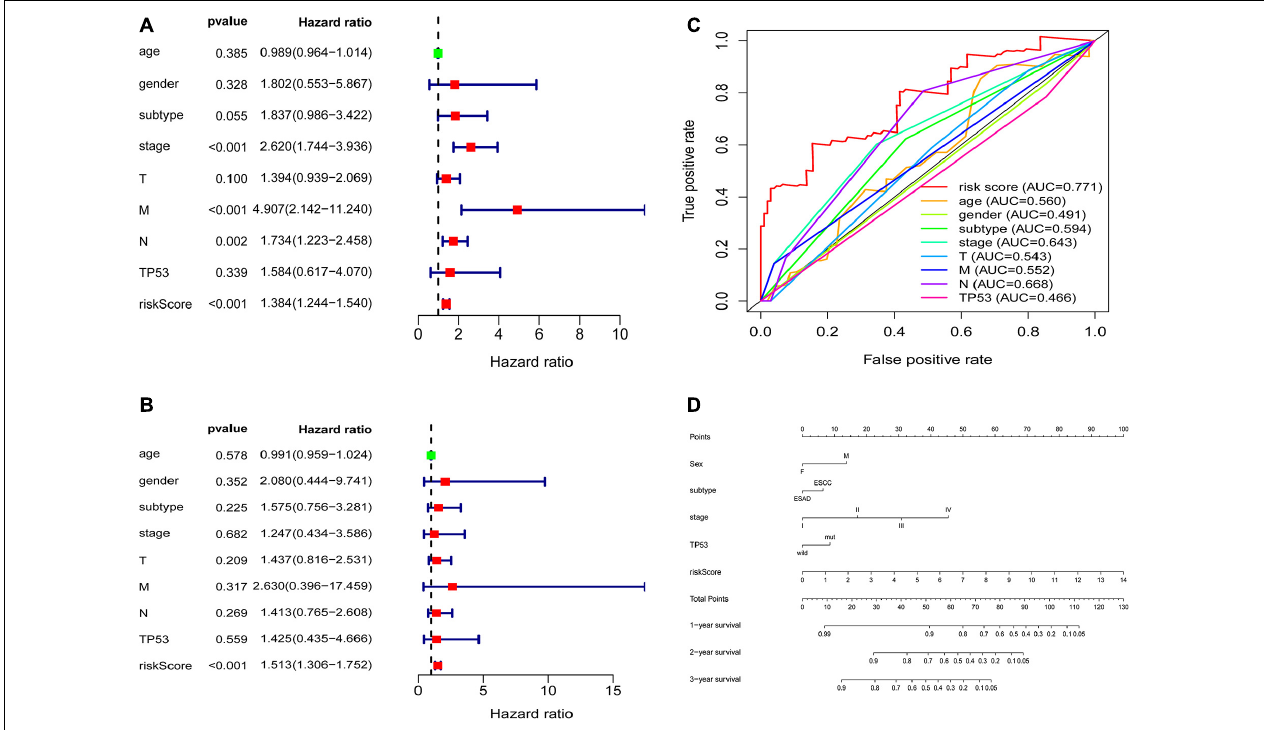
FIGURE 7 | Correlation between the seven-gene signature and patient clinical characteristics (A,B) Univariate and multivariate Cox regression analyses of the correlations between the TP53-associated signature and clinical characteristics with overall survival. (C) ROC curve analyses of age, sex, subtype, stage, T stage, M stage, N stage, TP53, and prognostic risk model. (D) Nomogram for predicting the 1-, 3-, and 5-year overall survival of patients with